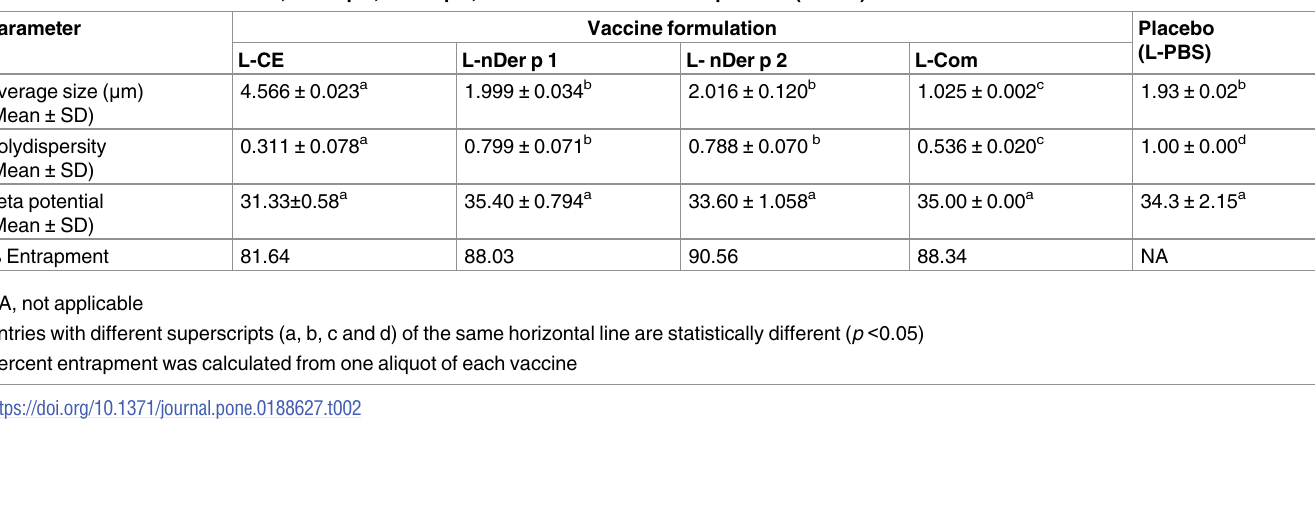
Table 2. Characteristics of L-CE, L-Der p 1, L- Der p 2, and L-Com vaccinesand placebo (L-PBS).